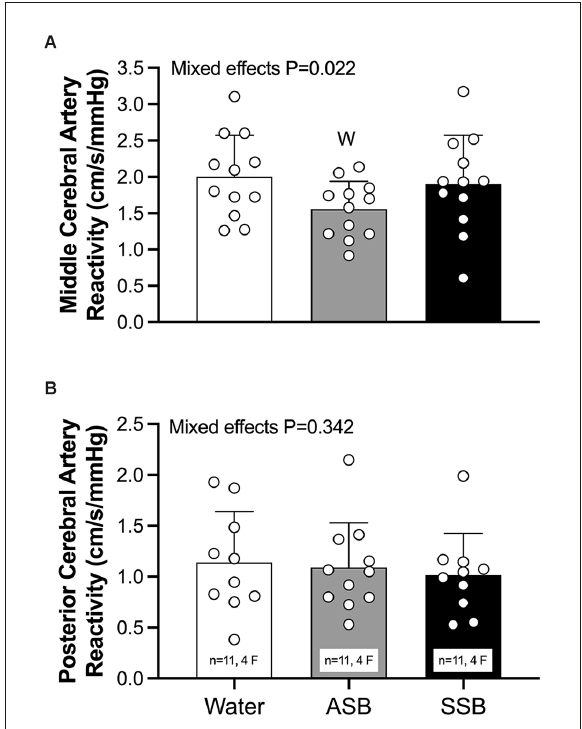
FIGURE5 Left middle cerebral artery (A) and right posterior cerebral artery (B) reactivity to hypercapnia. Mixed effects models were used to compare data between conditions. If a mixed effects model revealed a significant effect, a post-hoc Holm-Sidak multiple comparisons test was used to determine where differences existed. Data are presented as mean (bars) ± standard deviation and individual (circles) responses. n = 12, four females unless otherwise noted. Missing data occurred due to the loss of signal and/or inability to obtain a quality signal while maintaining the same depth and/or gain with the transcranial Doppler signal. W Different from Water ( P < 0.050); ASB, artificially-sweetened beverage; SSB, sugar-sweetened